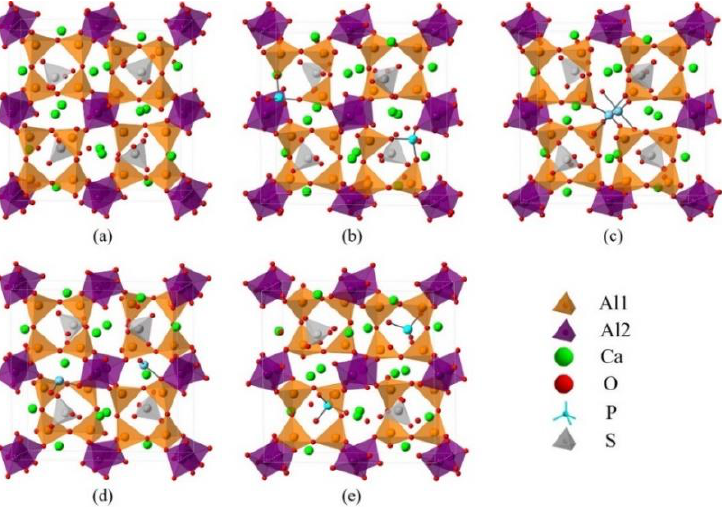
Figure 6. Crystalline structures of orthorhombic ye’elimite (ST) and the doped models (1 × 1 × 1), ( a ) pure, ( b ) P2@Al1, ( c ) P2@Al2, ( d ) P2@Ca, and ( e )